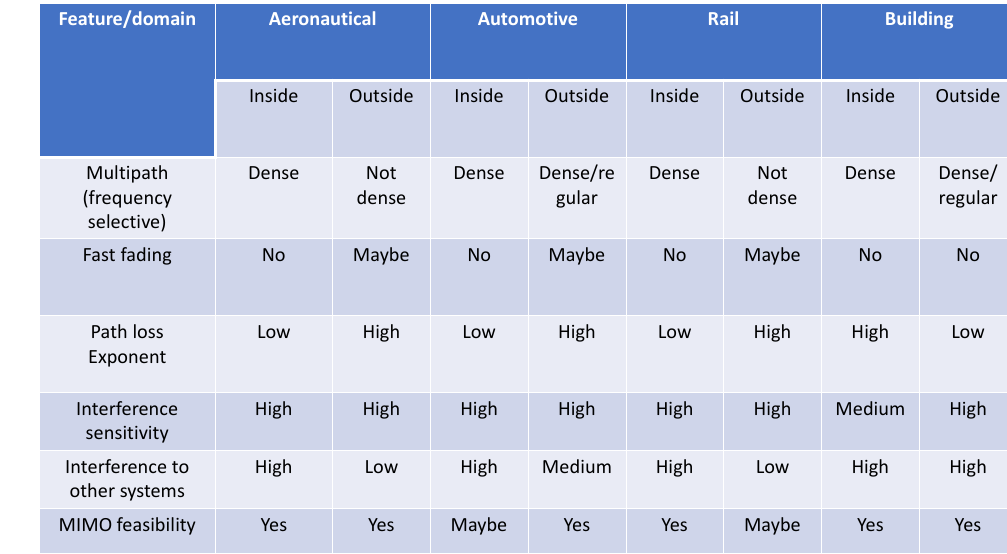
Figure 5. PHY-layer features of DEWI industrial domains.